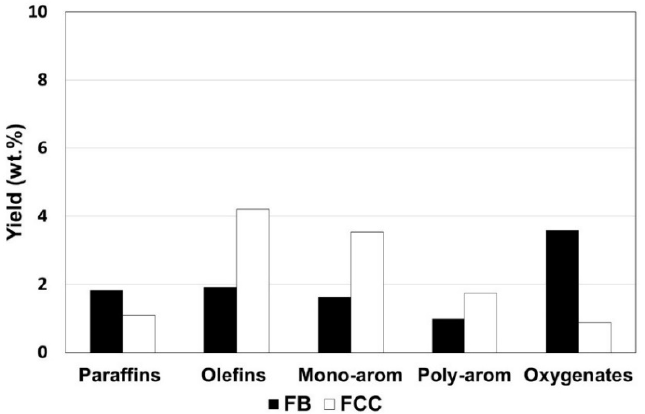
Figure 4. Yields of organic liquid products obtained by cracking 30% DX/n-hexane in hydrothermally treated beta catalyst at 500 °C. Legend: Mono-arom—monoaromatic; Poly-arom—polyaromatic; FB (Fixed Bed) and FCC (Fluid Catalytic Cracking).